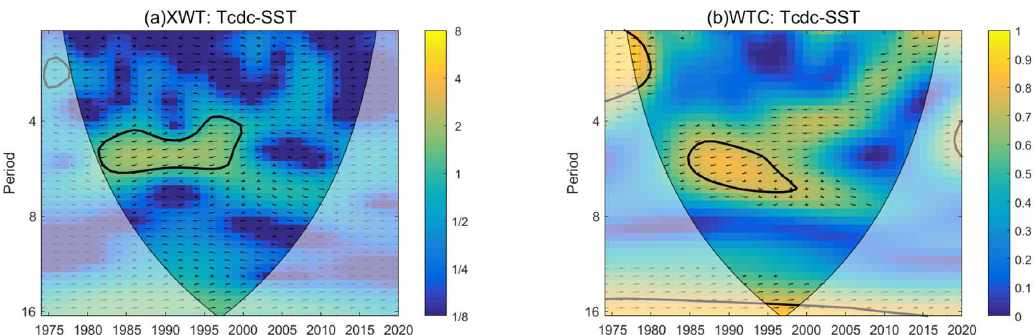
Figure 13. XWT of total cloud cover and SST in the tropical western Indian Ocean. ( a ) energy spec- trum; ( b ) condensation spectrum. spectrum; ( b ) condensation